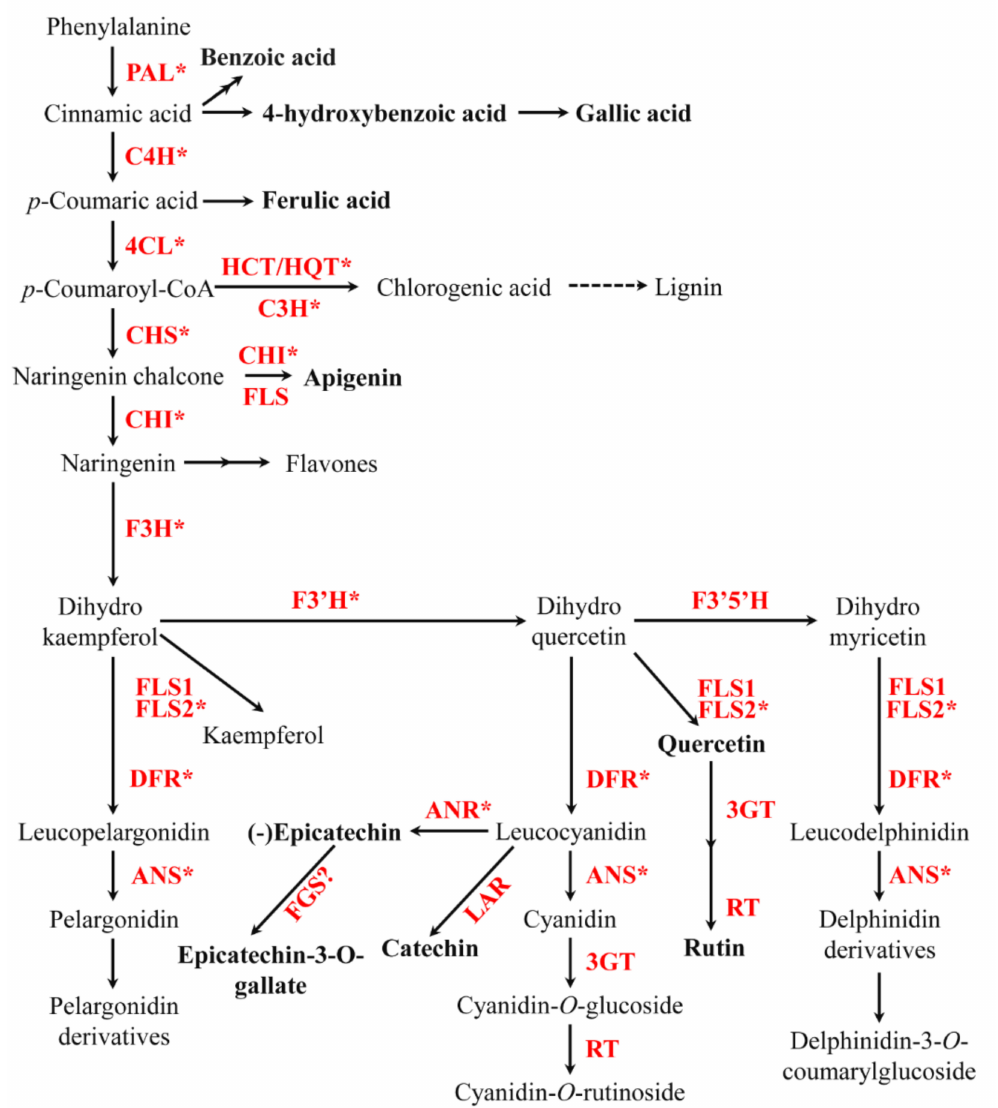
Figure 1. Proposed phenylpropanoid biosynthetic pathway in F. tataricum . The enzyme involved in each step is shown in red. The phenylpropanoid compounds measured in this study are shown in black and bold. Asterisks denote the genes used for gene expression analysis. PAL, phenylala- nine ammonia-lyase; C4H, cinnamic acid 4-hydroxylase; 4CL, 4-coumaric acid: CoA ligase; HCT, cinnamoyl-CoA shikimate/quinate transferase; HQT, hydroxycinnamoyl CoA:quinate